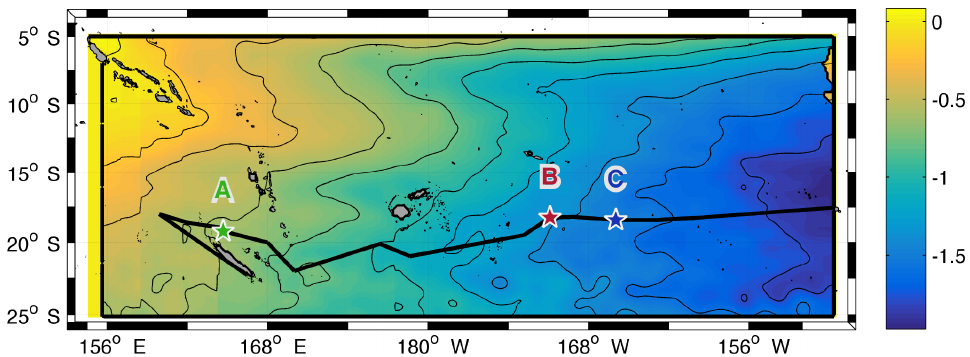
Figure 3. Total transport (Sv, colour bar) and stream function (black lines with contour interval of 0.25Sv) computed for 10 years with the total altimetry-derived surface velocity field. The ship track and locations of OUTPACE LD stations are indicated with the black line and coloured stars as in Fig.